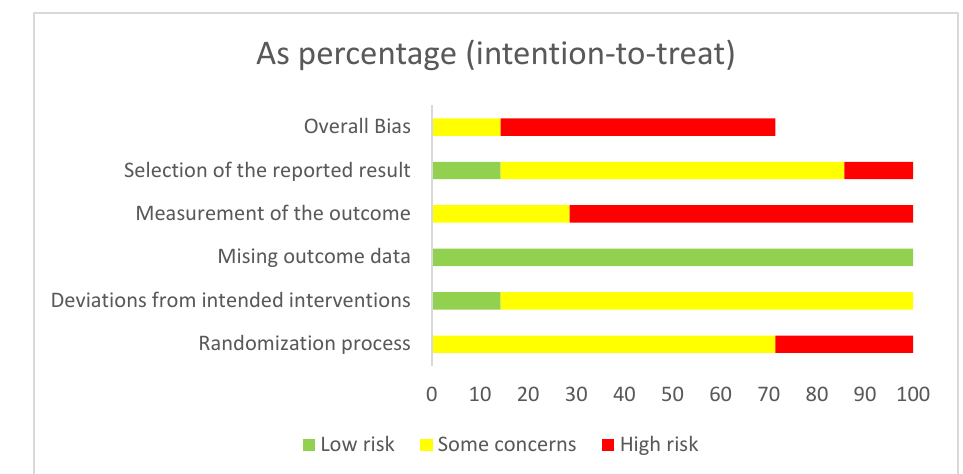
Figure 1. PRISMA flow diagram.